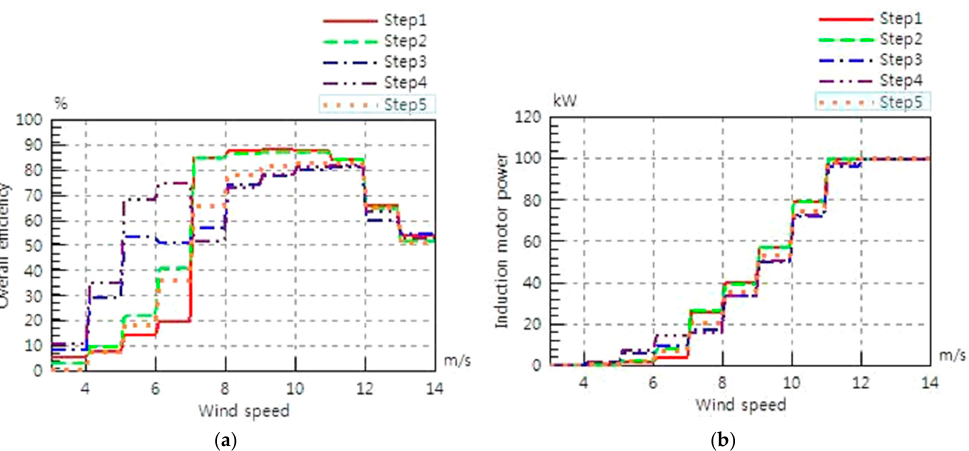
Figure 11. System efficiency analysis results according to powertrain combination. ( a ) Torque map and ( b ) Generation efficiency.